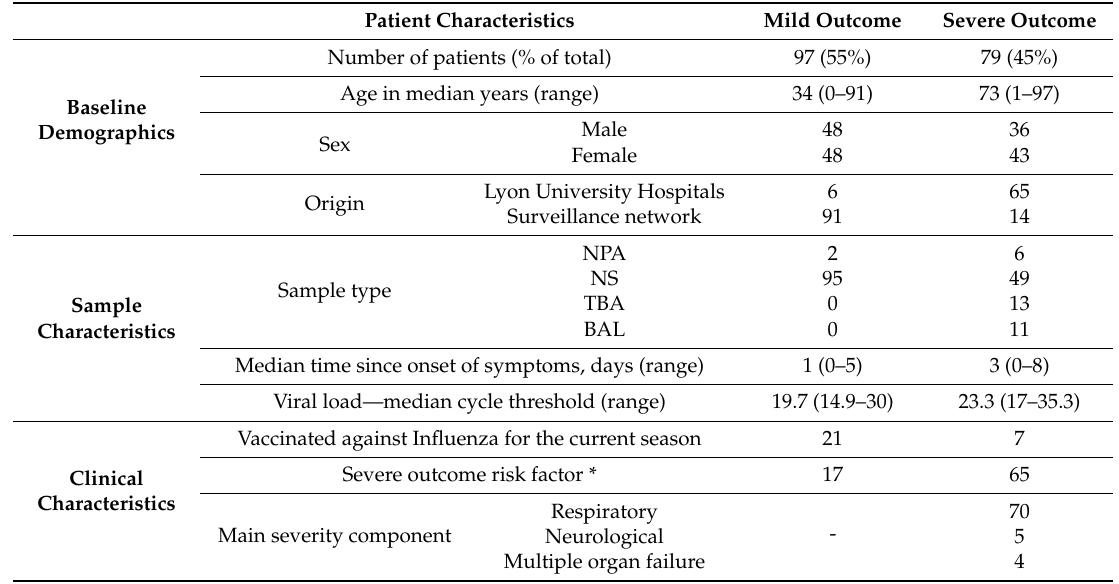
Table 1. Included patients baseline demographics and clinical and sequenced sample